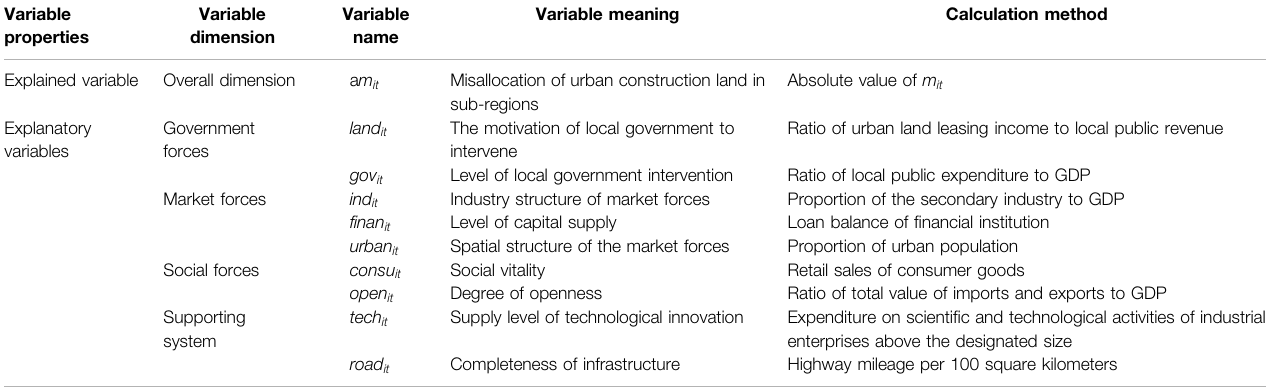
TABLE 4 | Variable selection for the multidimensional contributing factors of the SMCL. Variable